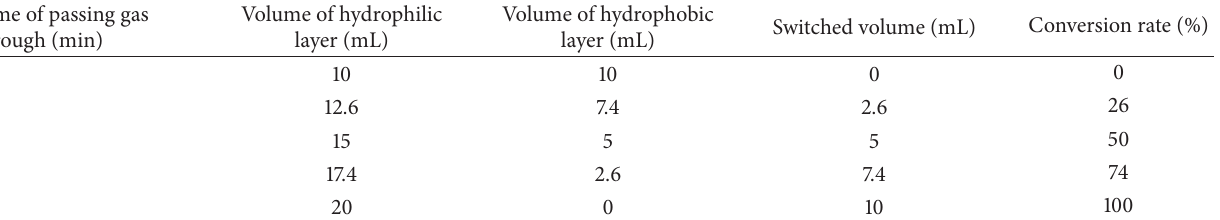
Table 3: Relationship between volume change of all phases and time of passing gas through when the deoiling agent switches from hydrophobicity to hydrophilicity.